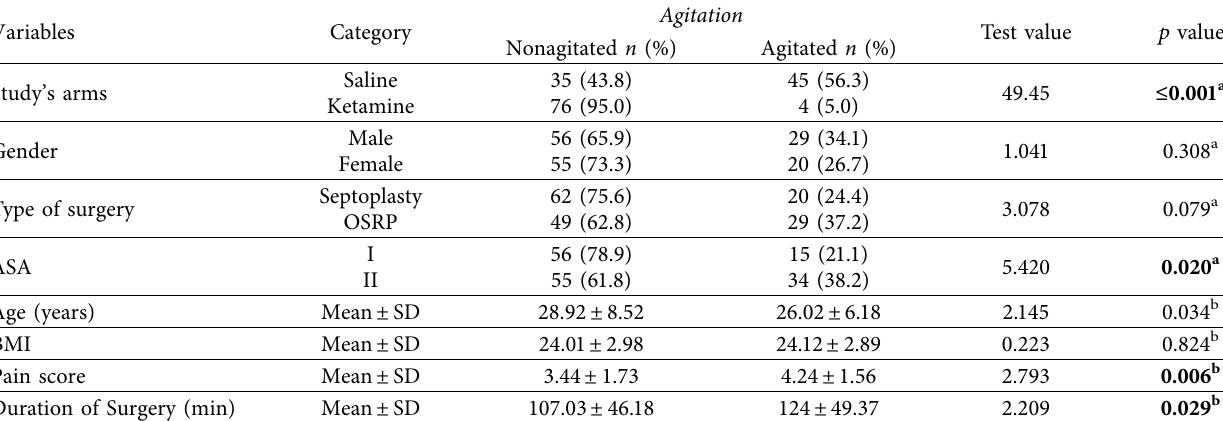
Table 3: Bivariate analysis for risk factors of postoperative agitation.